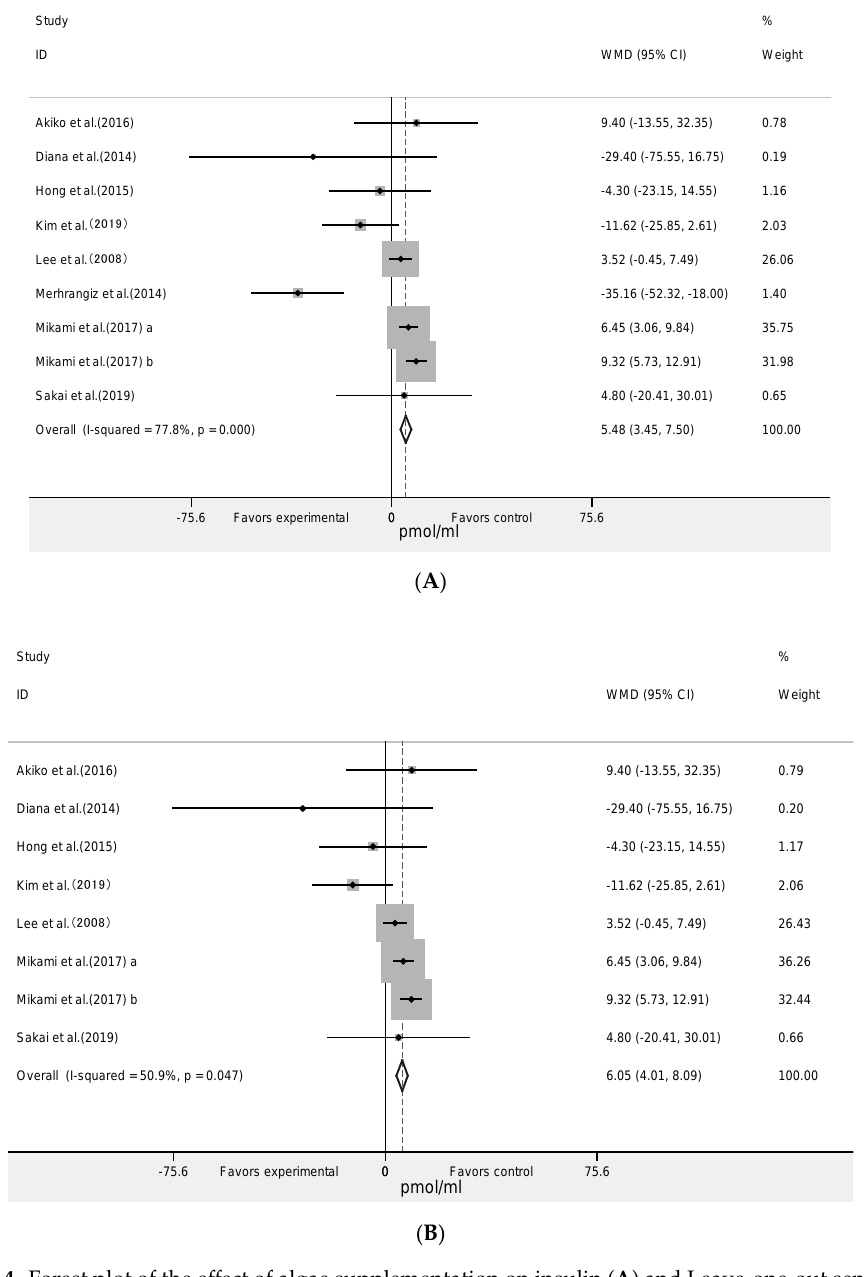
Figure 4. Forest plot of the effect of algae supplementation on insulin ( A ) and Leave-one-out sensitivity analysis of the impact of algae supplementation on insulin ( B ).